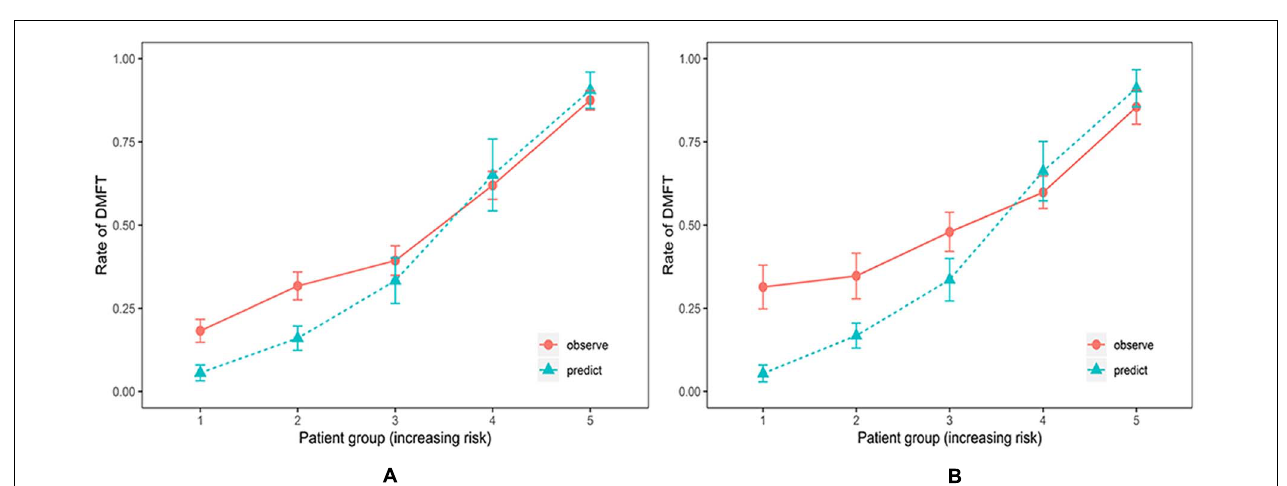
FIGURE 5 | Risk stratification plot for the training and testing cohort (Random Forest Model). Relationship between observed (orange, 95% confidence intervals) and predicted (green) scores of new carious lesions for 21 months for the training cohort (A) and the testing cohort (B) . The prediction model could accurately estimate risk for individuals at high and very high caries risk but underestimated risks for individuals at low and very low caries risk.